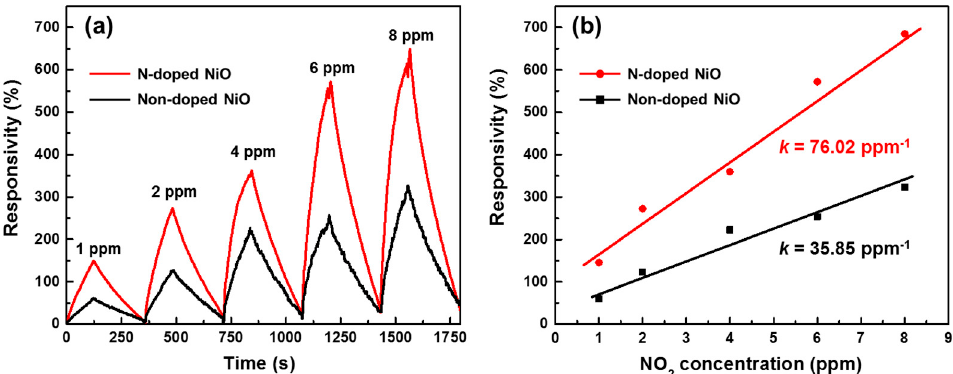
Figure 6. NO 2 sensing performance of N-doped and non-doped NiO NSs: ( a ) responsivity to various gas concentrations and ( b ) sensitivity plots.